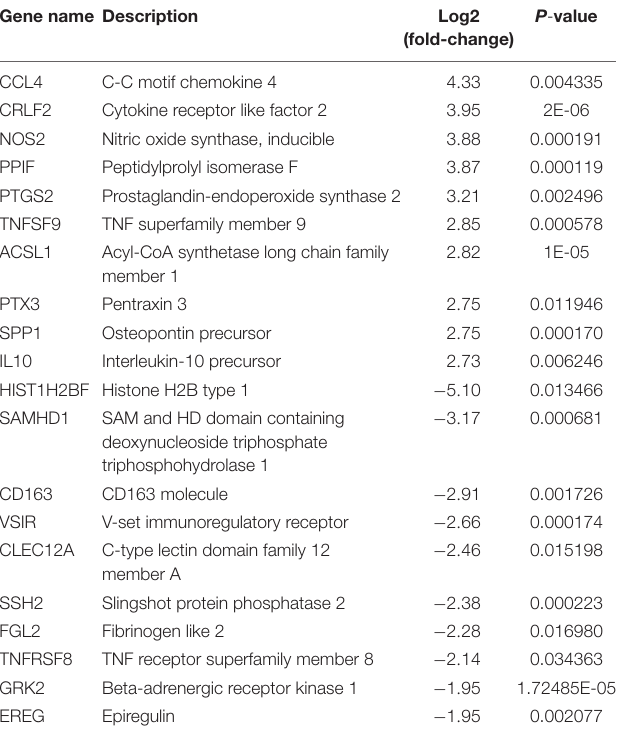
TABLE 1 | The top 20 upregulated and downregulated DE genes ( p -value ≤ 0.05) for MAP-infected vs. control monocytes-derived macrophage (MDM) samples at 6 hpi as ranked by